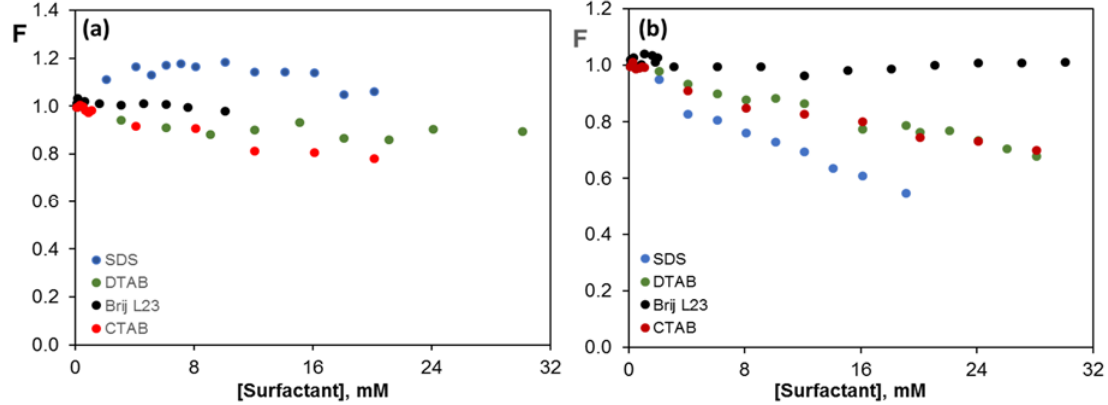
Figure 2. Change in the fluorescence (F) of vitamin B 6 ( λ exc = 325 nm; λ em = 395 nm) ( a ) and vitamin B 2 ( λ exc = 450 nm; λ em = 518 nm) ( b ) with increasing concentration of the different surfactants.